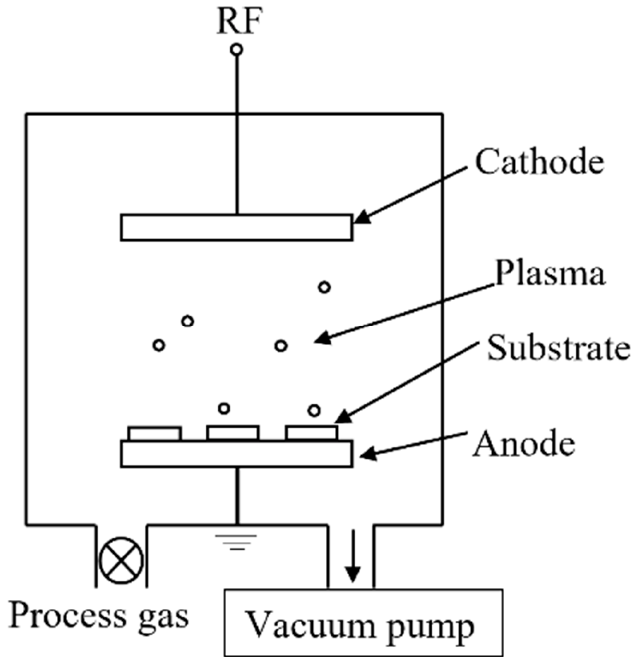
Figure 5. Working principle diagram of DC radio frequency plasma.